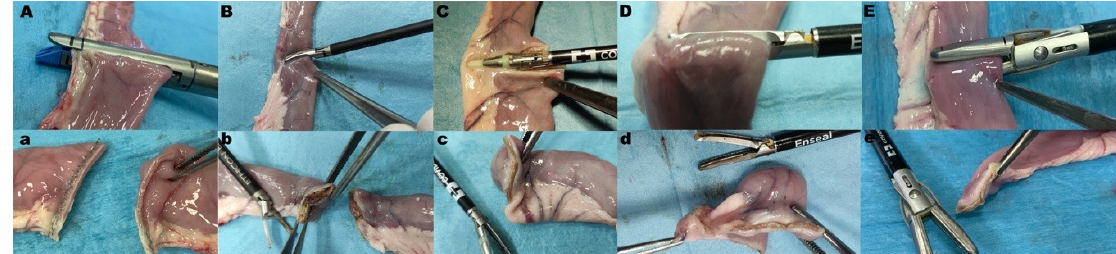
Figure 2. Representative pictures of device application for transection in study arm 1. Top row, during application; bottom row, after application. ( A , a ) Group S; ( B , b ) Group HS; ( C , c ) Group RFVS-1; ( D , d ) Group RFVS-2; ( E , e ) Group RFVS-3.